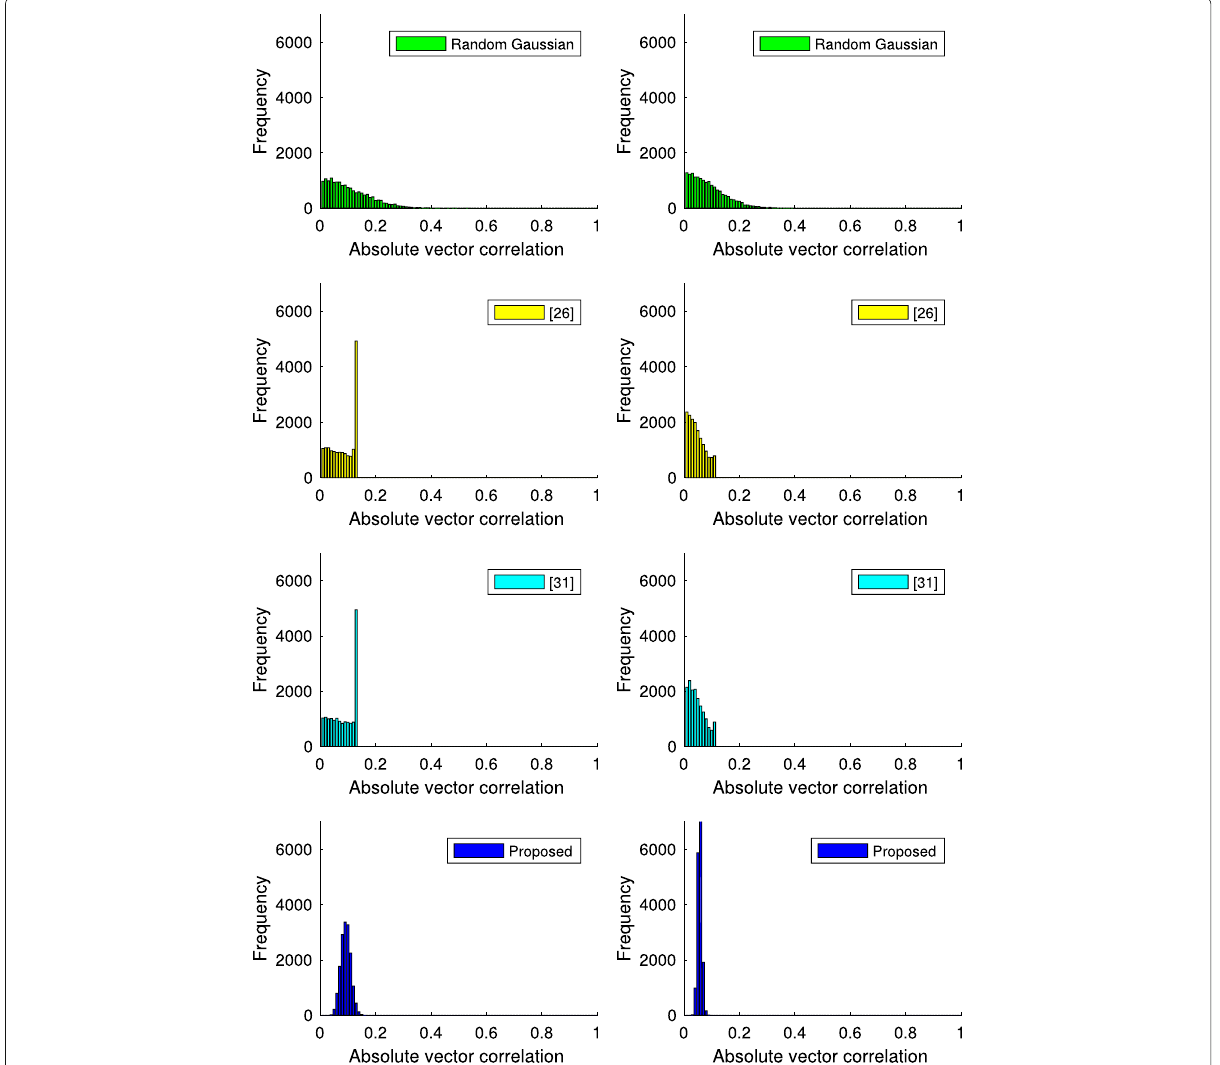
Fig. 2 Correlation distribution of frame vectors of 64 × 128 (left) and 96 × 128 (right) frames constructed with [26], [30] and proposed method. The optimal lowest bound (Welch bound) for these dimensions is μ opt = 0.0887 and μ opt = 0.0512,